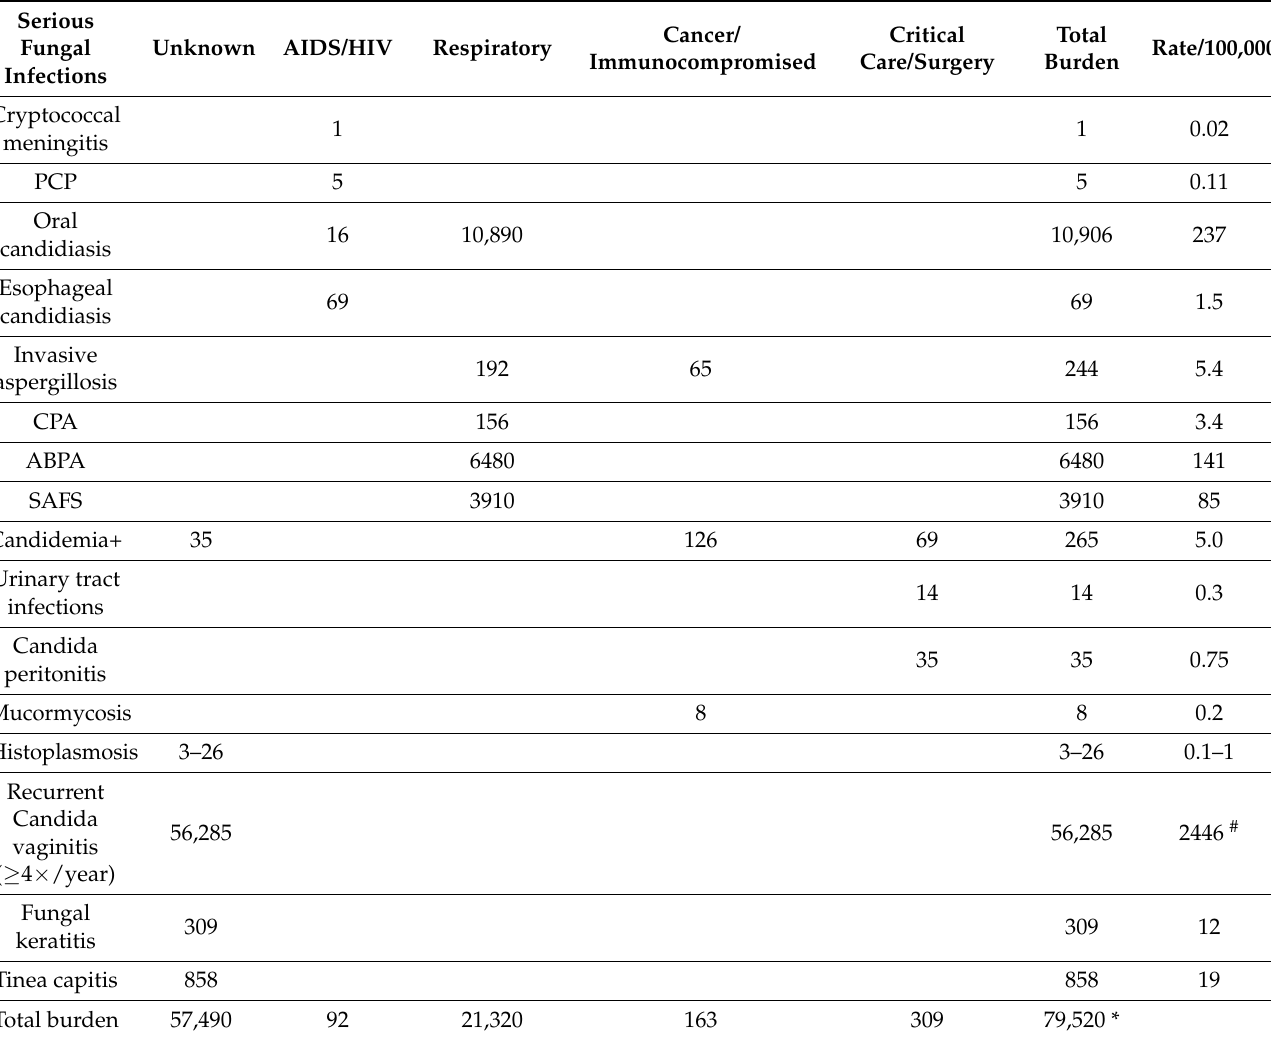
Table 4. Summary burden of fungal diseases in